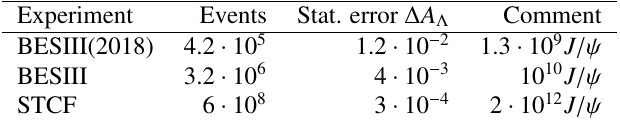
Table 2. Expected statistical uncertainties for A Λ from future